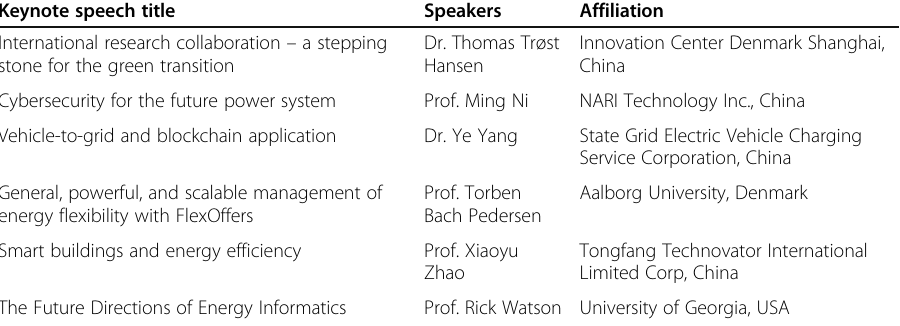
Table 2 Six keynote speeches at the Energy Informatics. Academy (EI.A) Asia 2021